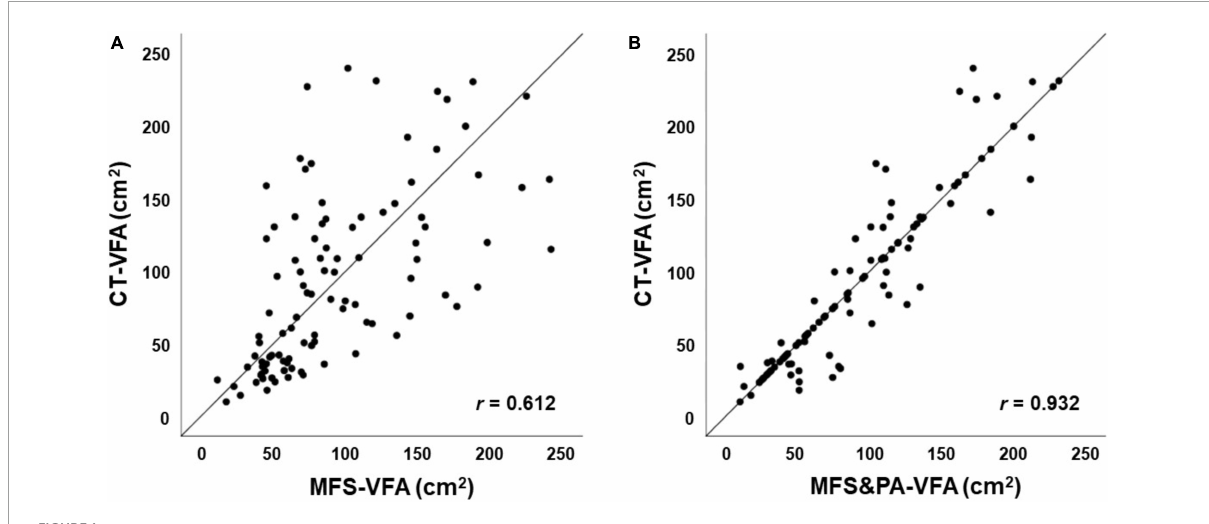
FIGURE1 Correlation between VFA by different methods. (A) MFS-VFA and CT-VFA; (B) MFS&PA-VFA and CT-VFA. CT, computed tomography; VFA, visceral fat area; CT-VFA, VFA measured by CT; MFS-VFA, VFA measure by a multifrequency segmental bioelectrical impedance analysis (BIA) machine (InBody770 R (cid:13) ); MFS&PA-VFA, VFA measured by a new MFS-BIA machine combined with a portable abdominal BIA device (InBody970 R (cid:13) + Y-scope R (cid:13)